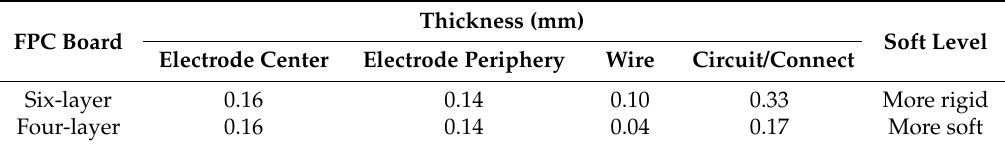
Table 2. The thickness of flexible printed board (FPC).